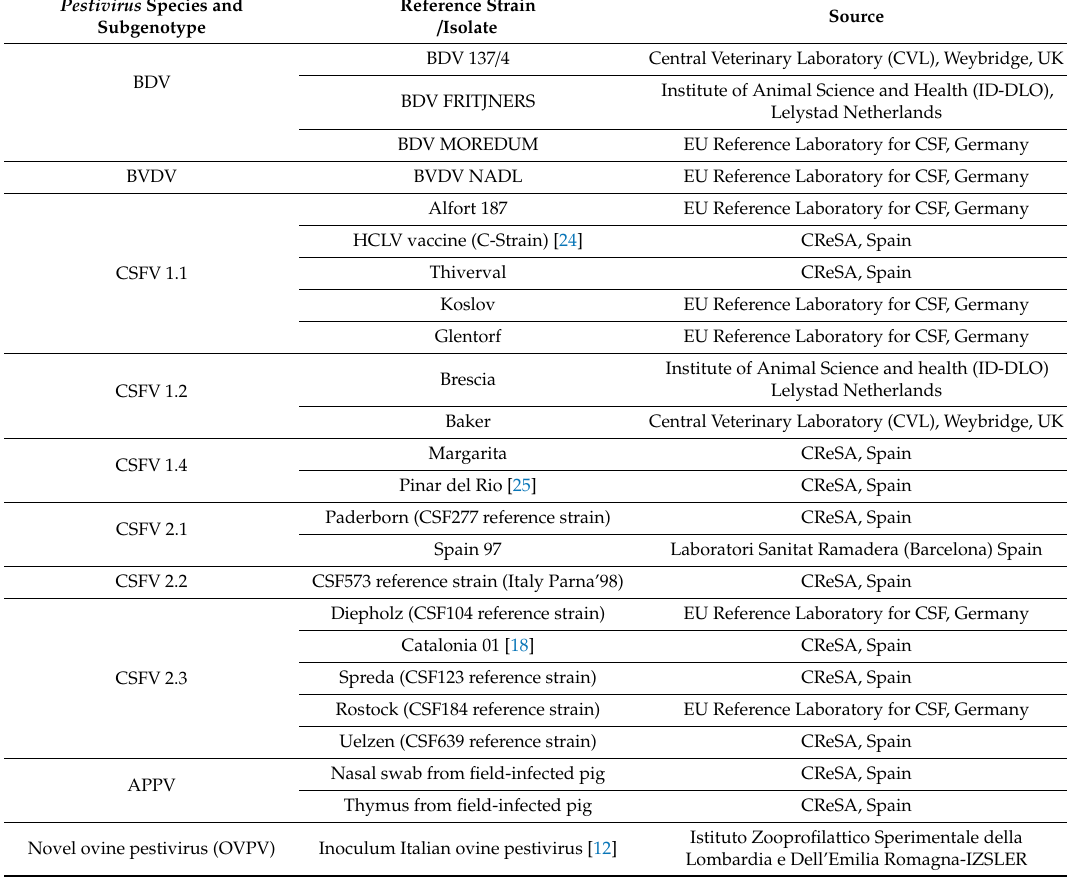
Table 1. Viruses used in the validation of ovine pestivirus real-time TaqMan